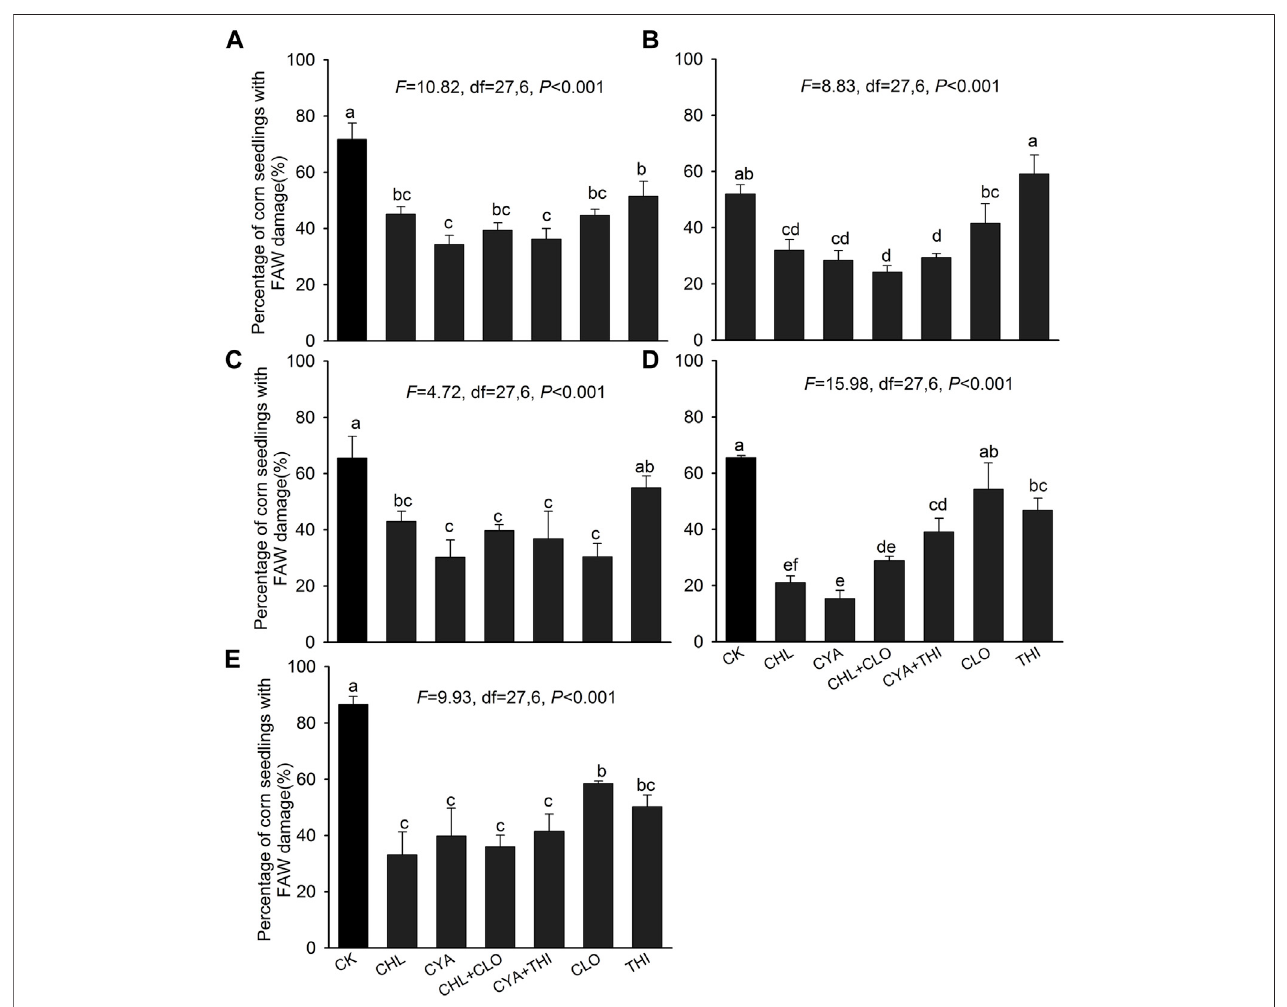
FIGURE 1 | Percentage of corn seedlings damaged by FAW in laboratory experiments corn where seeds were treated with chlorantraniliprole (CHL), cyantraniliprole(CYA),clothianidin(CLO),thiamethoxam(THI),CHL+CLOandCYA+THI;CKistheuntreatedcontrol.Damageisshownoncornseedlingssubjectedto